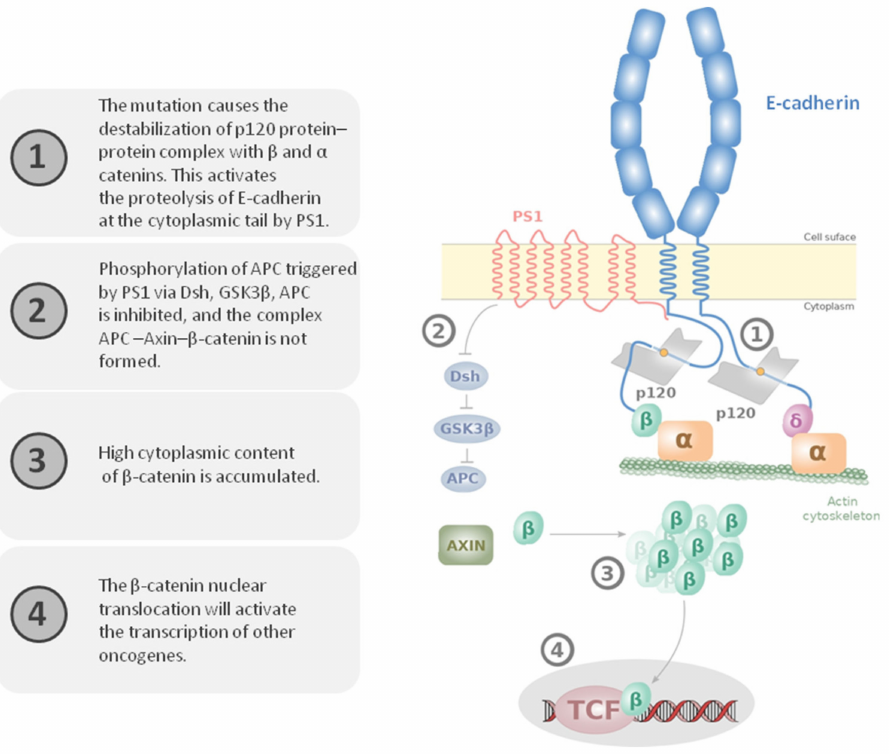
Figure 6. E-cadherin/ β -catenin signaling pathway alteration in the presence of p.G761R (inspired from